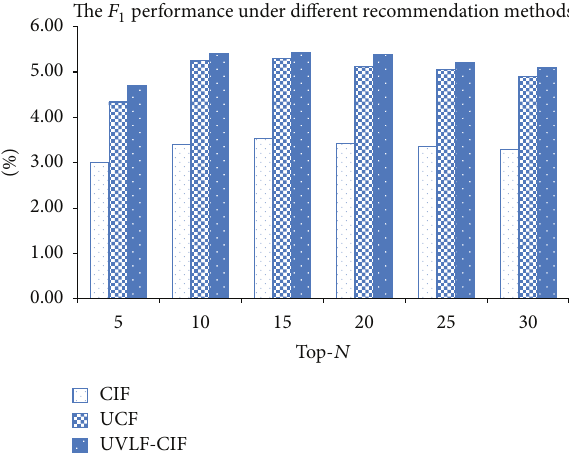
Figure 2: Comparing the effect of contact strength under different values of Top- 𝑁 items.